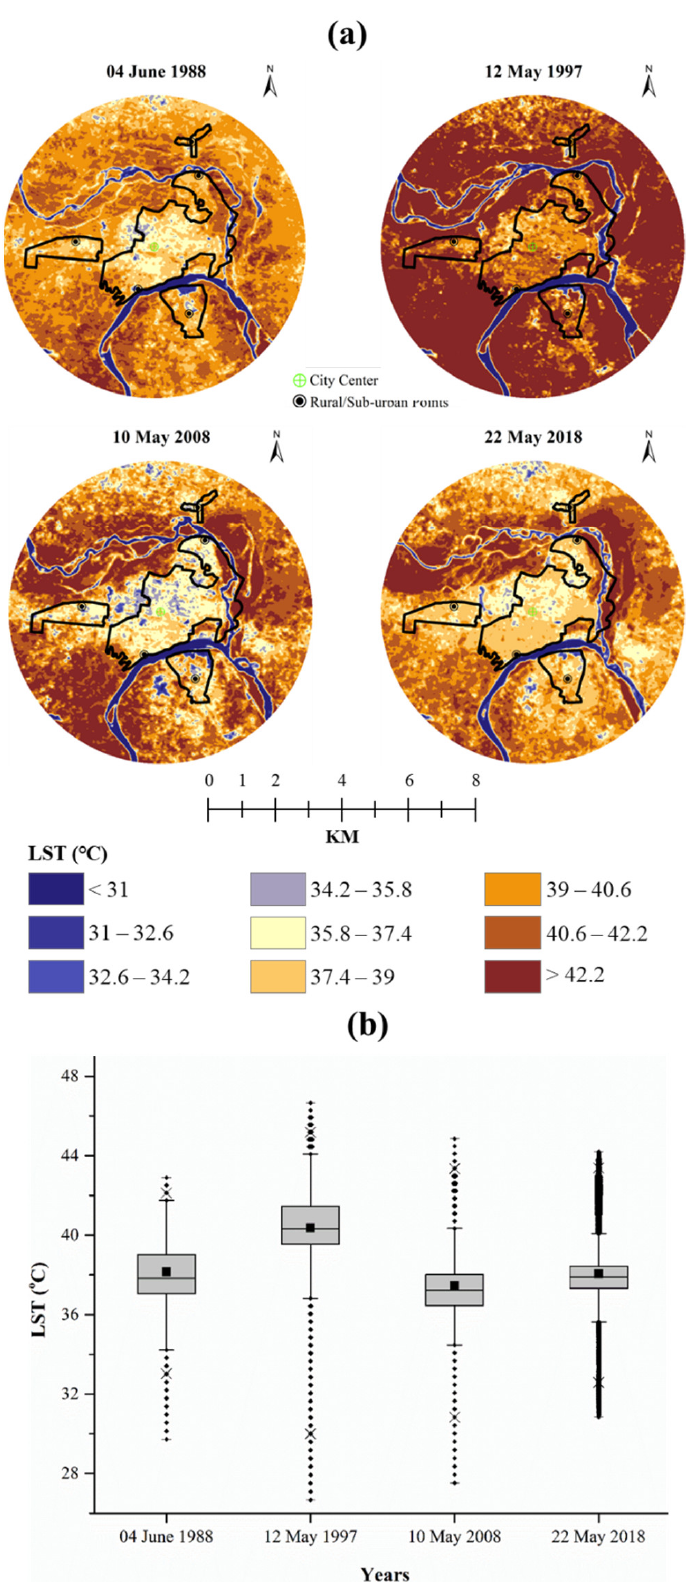
Figure 3. Spatiotemporal dynamics of LST in the summer season over Prayagraj city: ( a ) LST maps during 1988–2018 (five rural/suburban areas shown here used for computing SUHI) and ( b ) boxplots of LST dynamics during 1988–2018.